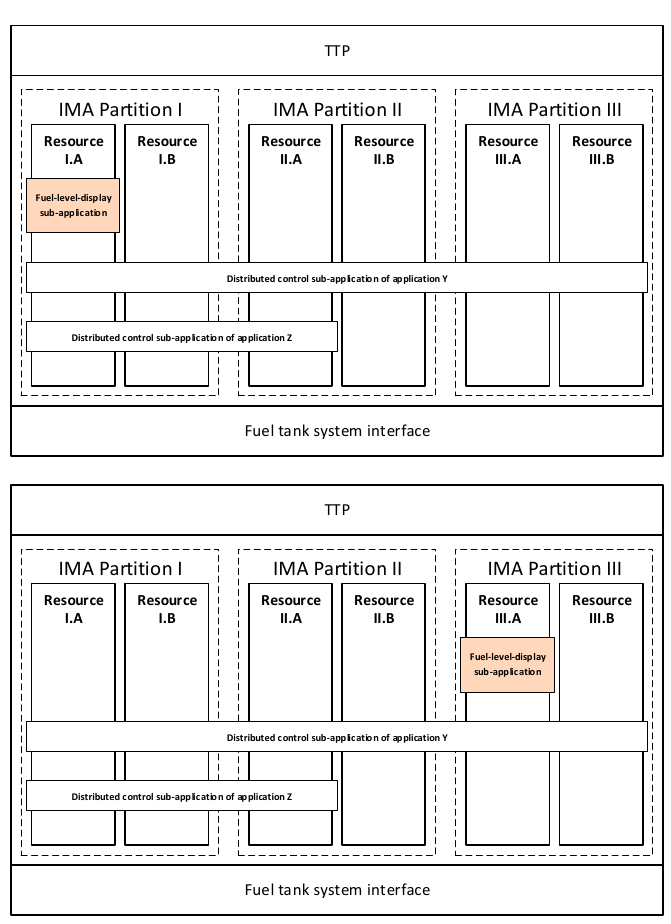
Figure 9. CPIOM-Monitoring device: device configuration for scenario 1 ( top ); Device configuration for scenario 2 ( bottom ).